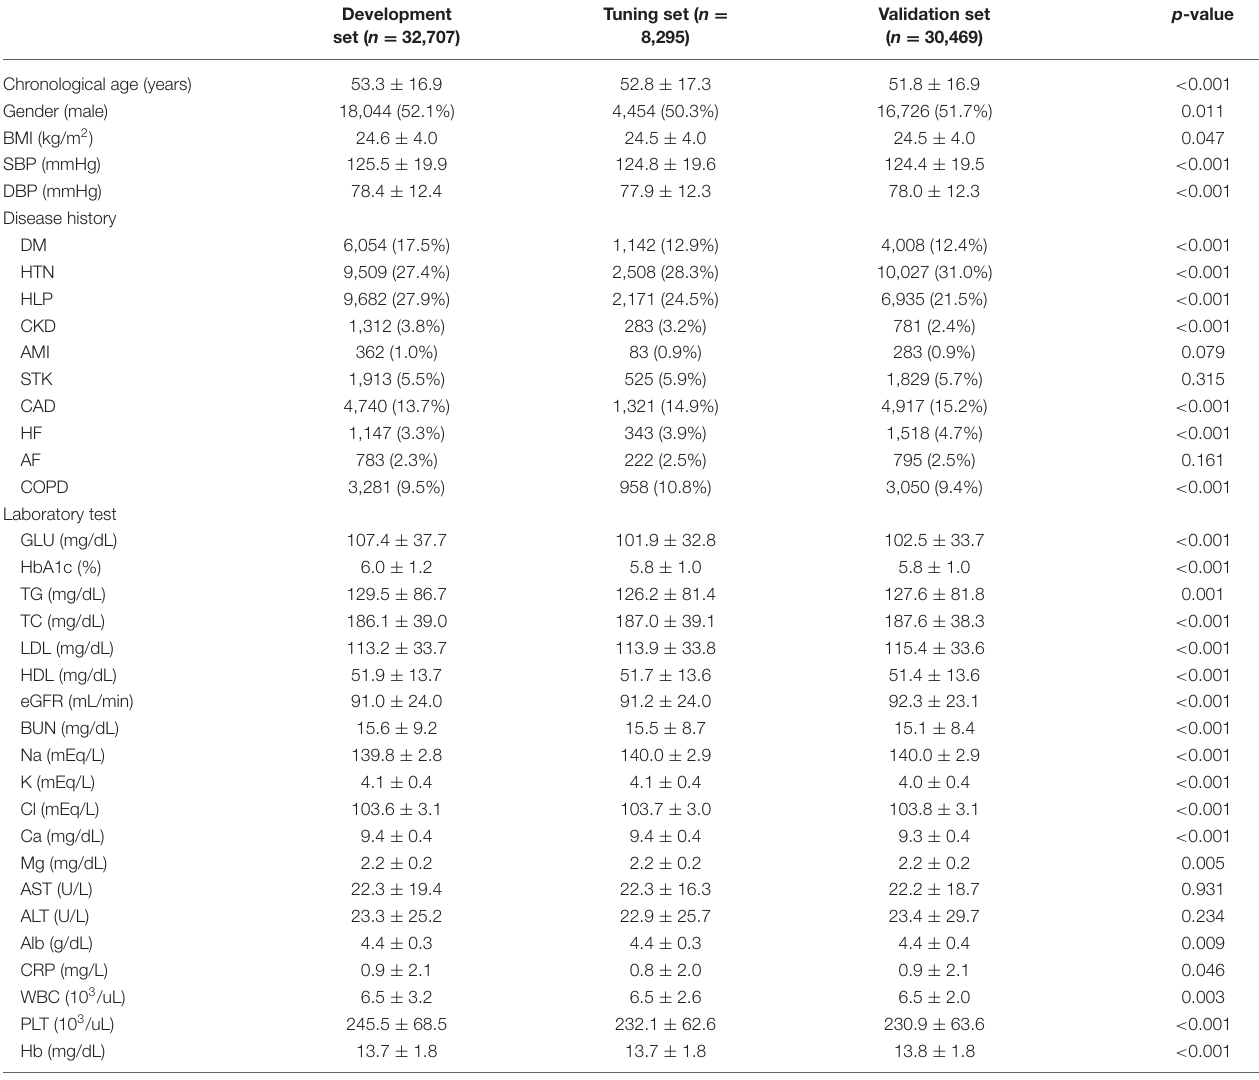
TABLE 1 | Characteristics of the patient and laboratory results in the development, tuning, and validation sets.